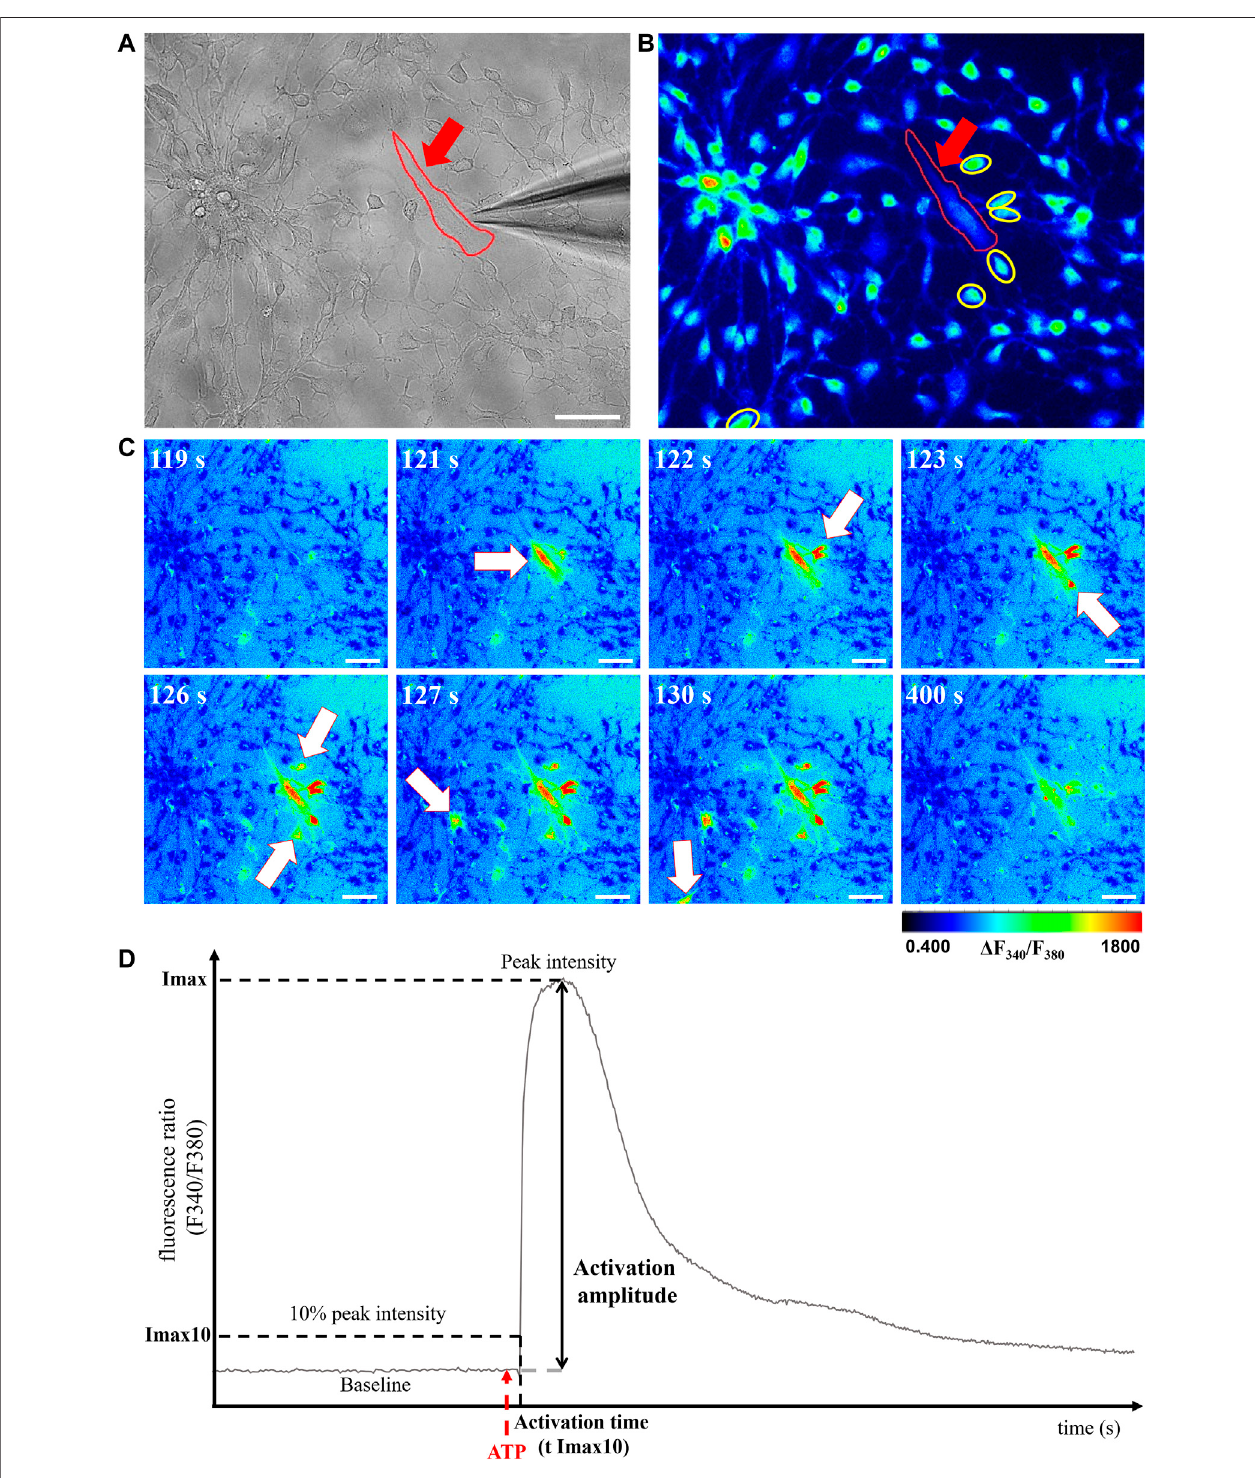
FIGURE 7 | Evaluation of GJIC between retinal Müller cells and astrocytes. (A,B) Calcium imaging. Müller cells (red arrow) can be morphologically distinguished fromastrocytes(yellowcircles) underbright fi eld (A) and fl uorescent (B) modes. (C) ATP-stimulatedcalciumresponseoftheMüllercellandneighboringastrocytescould be monitored under fl uorescent microscopy as a function of time (white arrows). Pseudocolor images were obtained by the 340 nm/380 nm fl uorescence ratio and the pseudocolorscaleindicates fl uorescence ratiovalues. (D) Graphicalrepresentationofastrocytescalciumresponsecurveswiththeparametersselectedforfurther analyses:cellactivationthreshold(Imax10),activationamplitude(%ofbaselineincrease)andcellactivationthresholdtime(TImax10)wereanalyzed.Scalebars=50 µm.